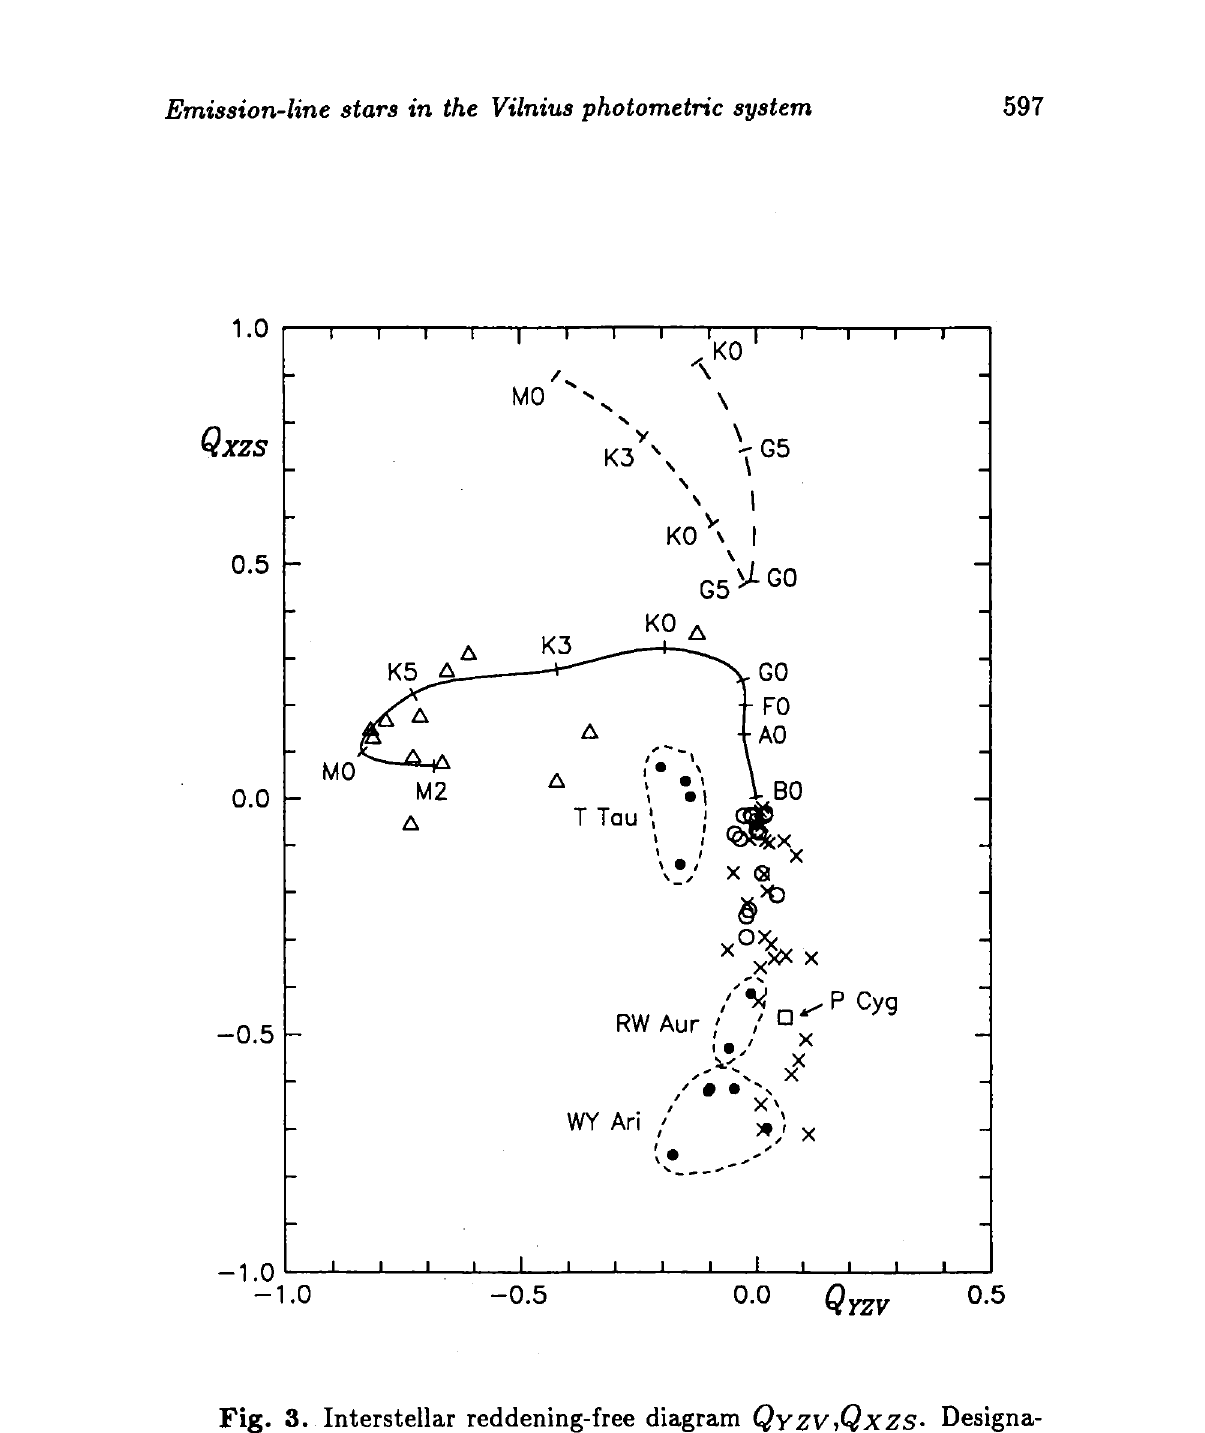
Fig. 3. Interstellar reddening-free diagram QYZV,QXZS· Designa- tions are the same as in Fig.